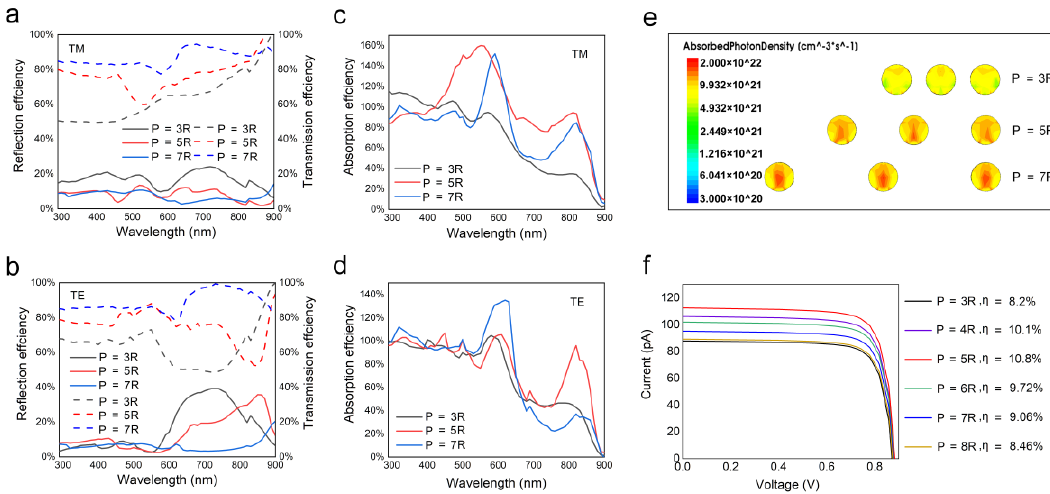
Figure 3. ( a , b ) The reflectance and transmittance of the HNA structures with di ff erent periods for TM and TE polarized light, respectively. ( c , d ) The absorptance of HNA structures with di ff erent periods for TM and TE polarized light, respectively. ( e ) The cross-sectional optical generation profiles of HNA structures with di ff erent periods. ( f ) The current–voltage characteristics of HNA structures with di ff erent